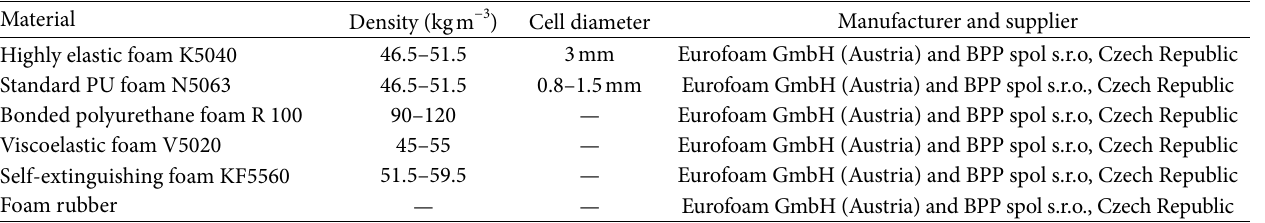
Table 1: Parameters of various samples used in the